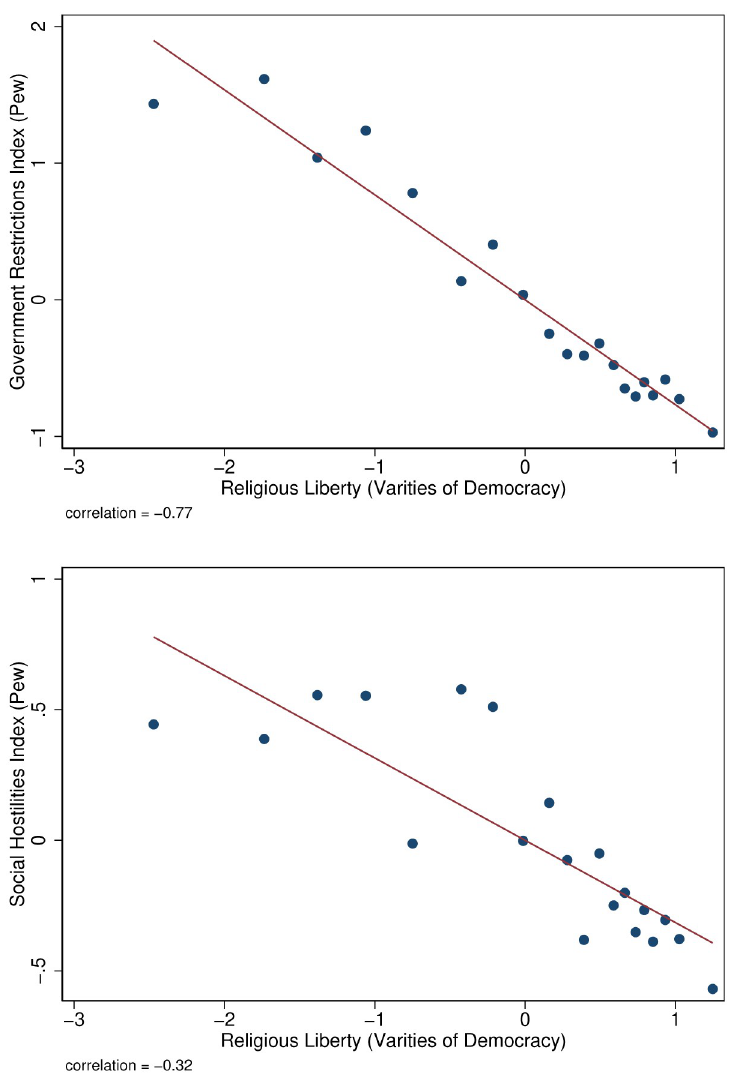
Fig 2. Comparison of varieties of democracy and Pew research data. Sources: Varieties of Democracy (“V-Dem”) Pew Research Center, 2007, 2016, 2017. The figures plots the standardized z-scores of religious liberty from V-DEM and government restrictions and social hostilities from the Pew Research